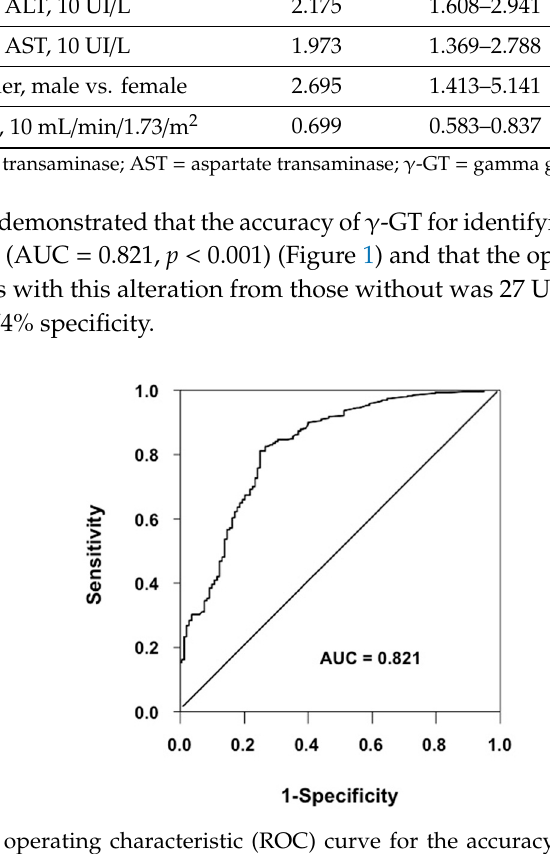
Table 5. Multiple logistic analysis of endothelial dysfunction in Subgroup A ( n = 247).